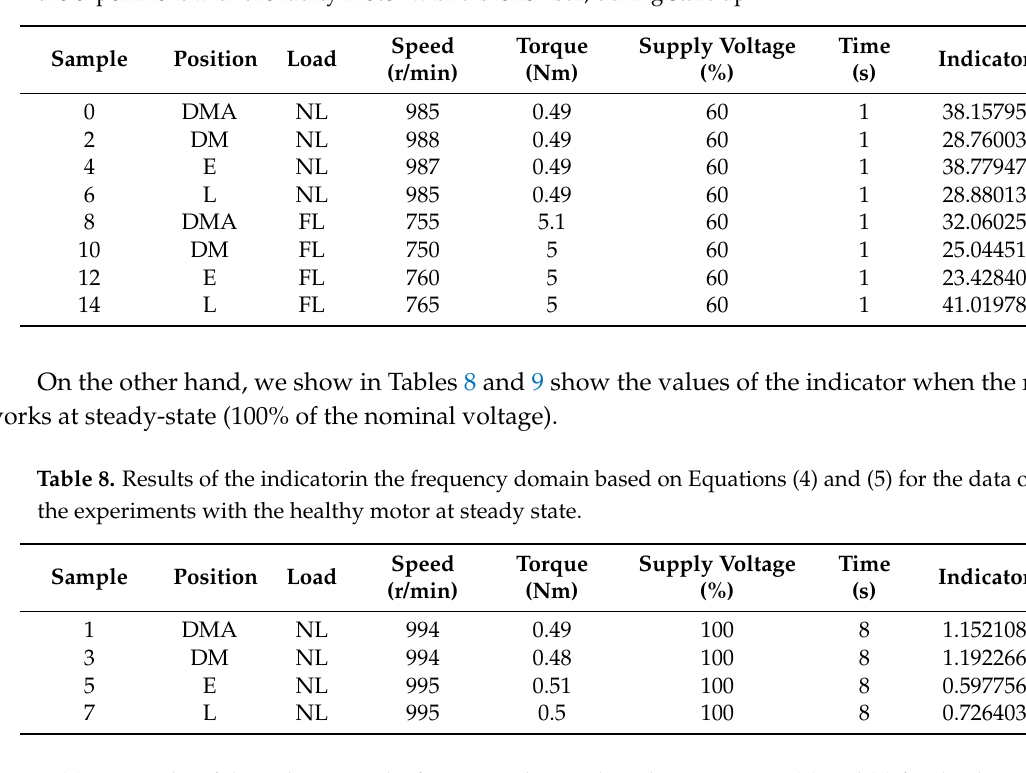
Table 9. Results of the indicator in the frequency domain based on Equations (4) and (5) for the data of the experiments with the faulty motor with a broken bar at steady